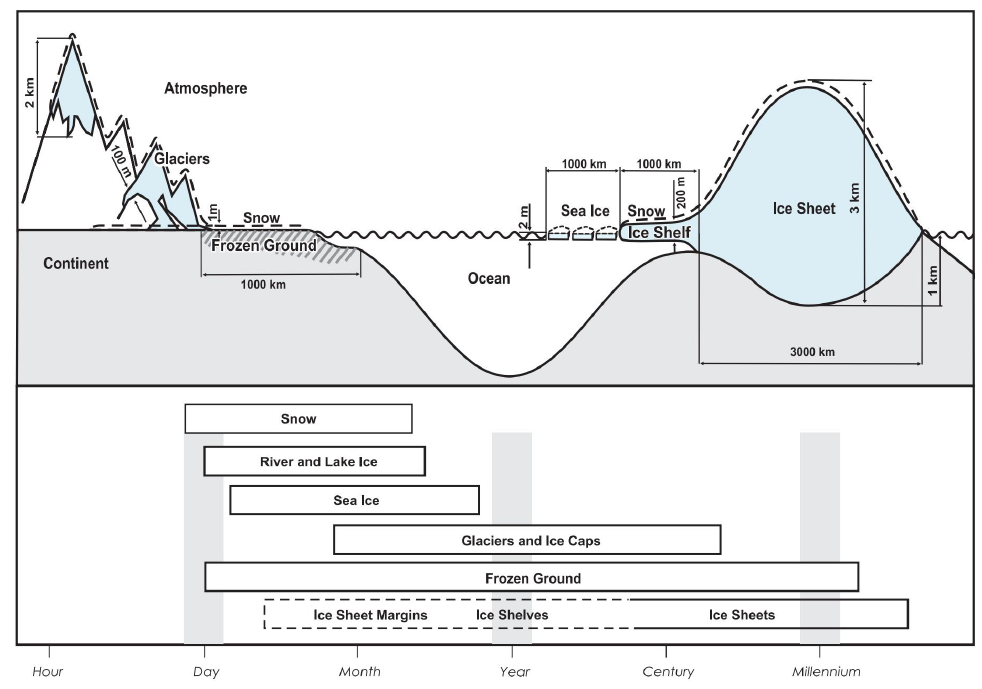
Figure 1. Components of the cryosphere and their time scales (modified from Ref. [1]).